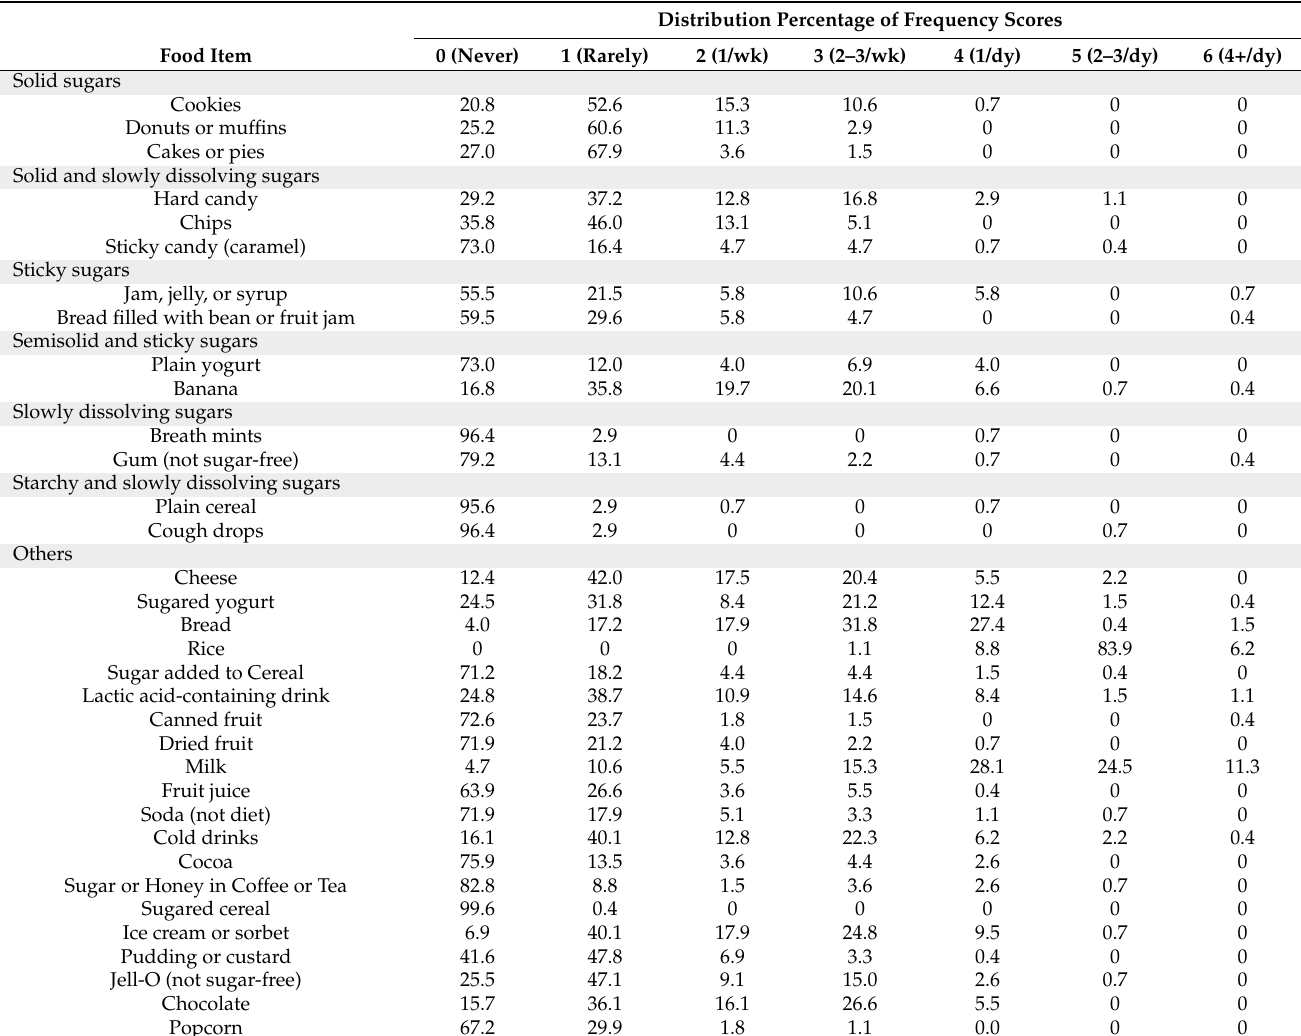
Table 2. Distribution of the frequency scores for each food item ( n =